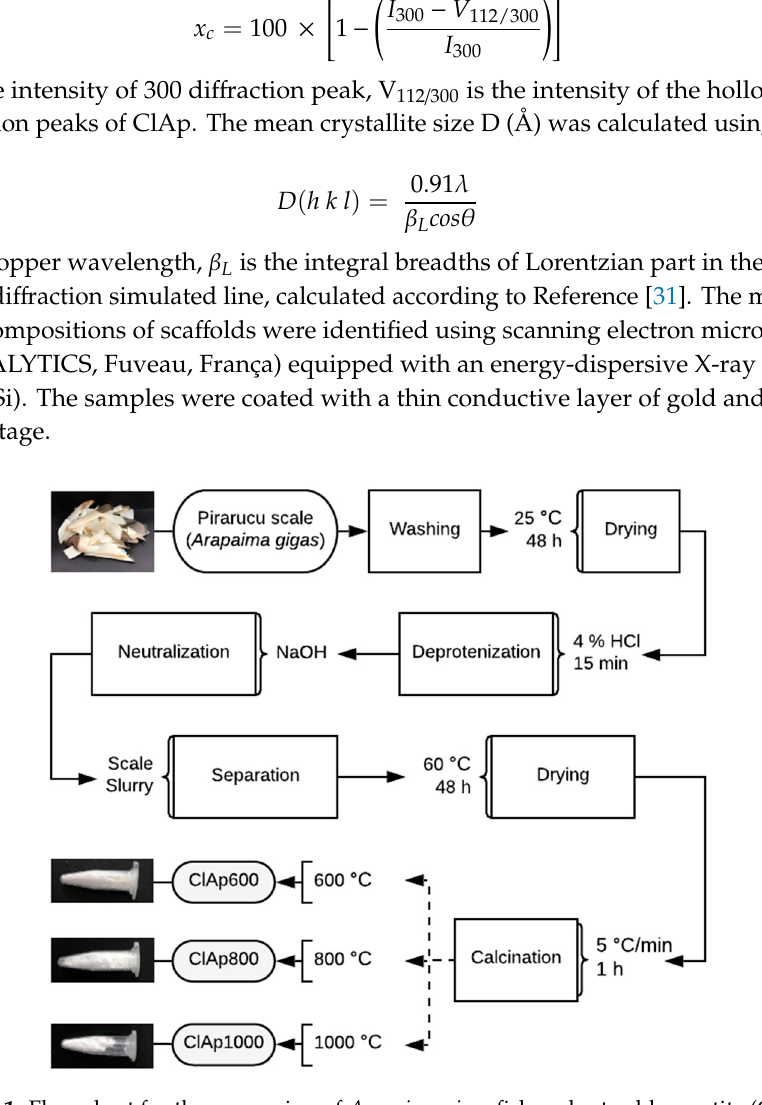
Figure 1. Flow chart for the processing of Arapaima gigas fish scales to chlorapatite (ClAp).